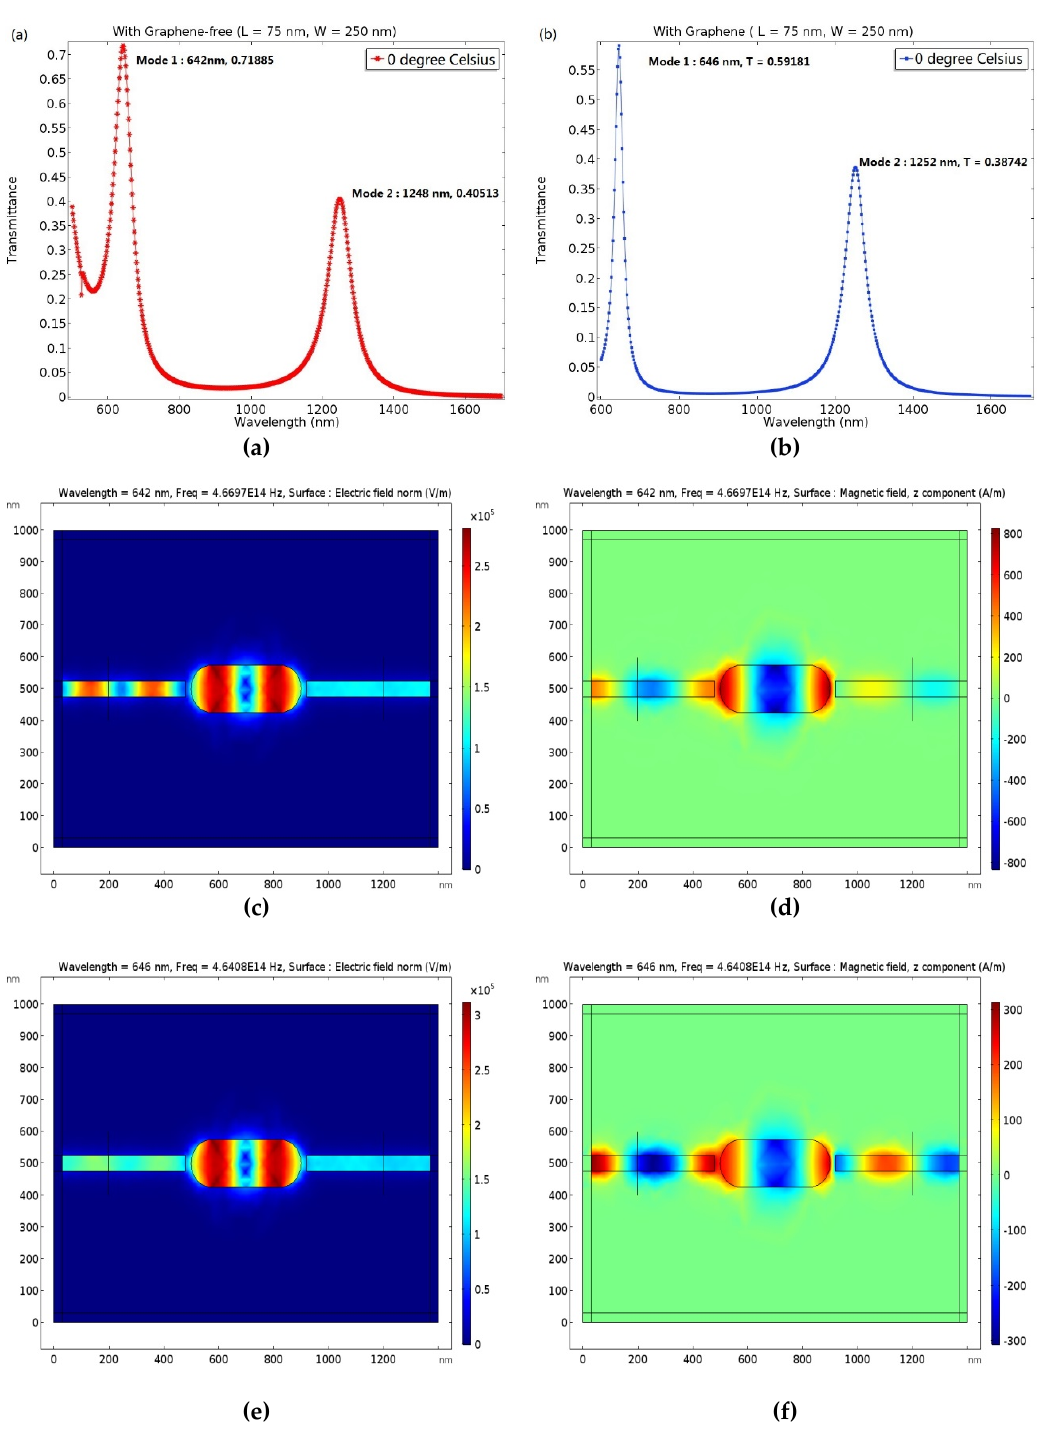
Figure 3. Transmittance of the plasmonic resonator sensor with graphene-free ( a ) and with graphene ( b ) versus different wavelengths at 0 ◦ C. The structural parameters of resonator are L = 75 nm and W = 250 nm, respectively. ( c ) Electric field norm distribution of the plasmonic sensor without graphene at 0 ◦ C and 642 nm. ( d ) Magnetic field distribution of the plasmonic sensor without graphene along the z axis at 0 ◦ C and 642 nm. ( e ) Electric field norm distribution of the plasmonic sensor with graphene at 0 ◦ C and 646 nm. ( f ) Magnetic field distribution of the plasmonic sensor with graphene along the z axis at 0 ◦ C and 646